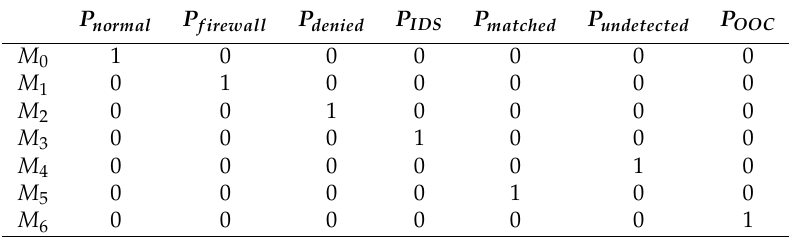
Table 9. Reachable markings’ set of Scenario II.